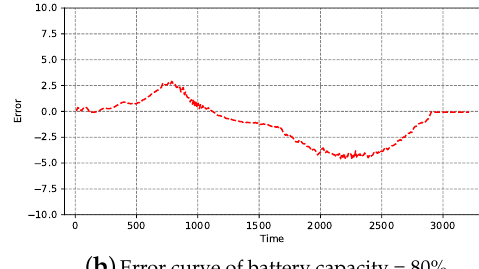
( b ) Error curve of battery capacity = 80% Figure 12.